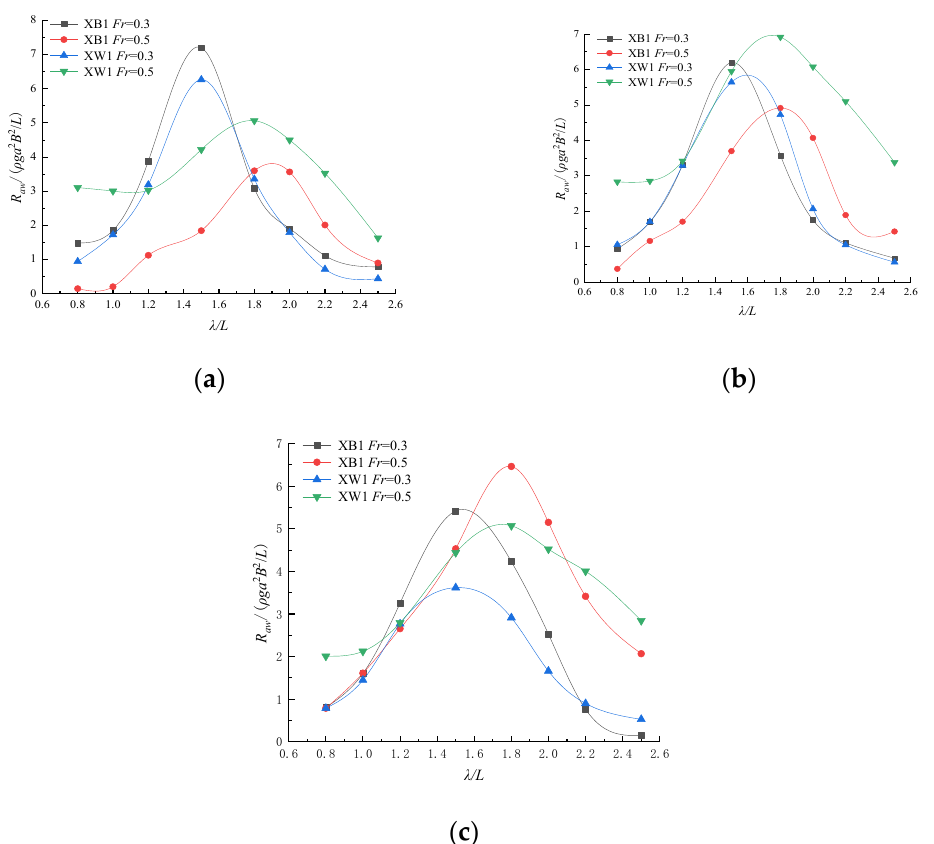
Figure 9. Computed results for ‘XB1’ and ‘XW1’ moving in waves with different wave conditions: ( a ) H = 0.04 (m), ( b ) H = 0.08 (m), ( c ) H = 0.12 (m). Figure 8a,c,e present the heave responses for wave heights of 0.04 m, 0.08 m and 0.12